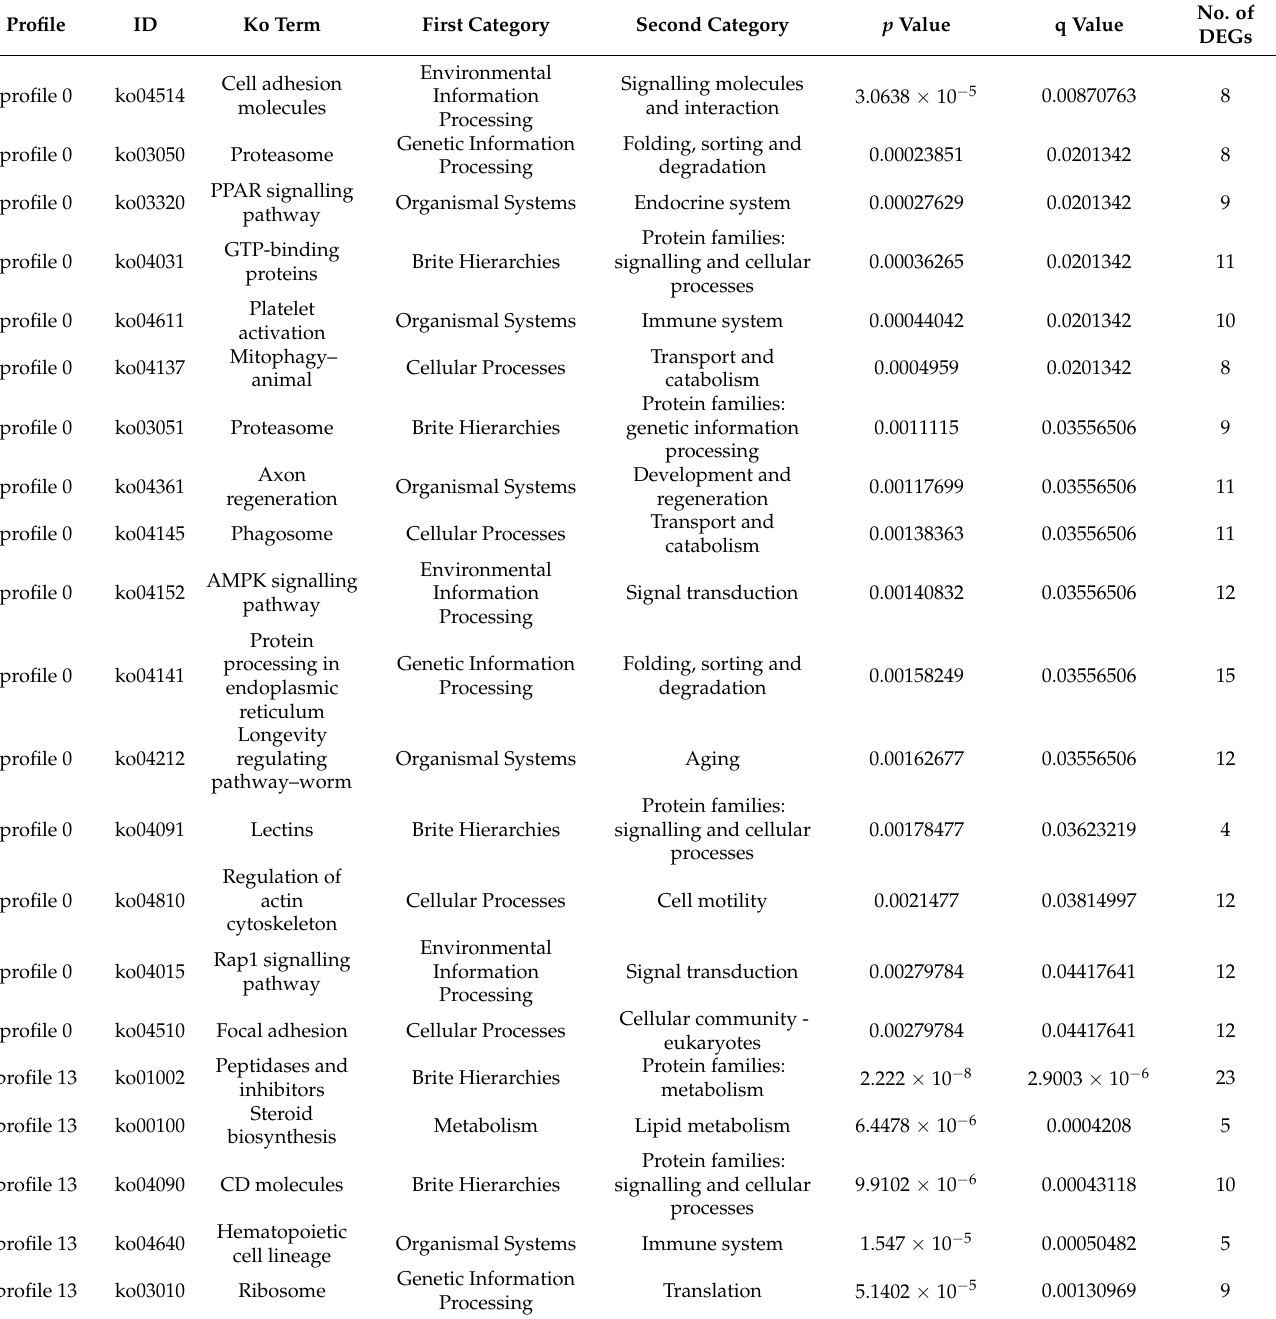
Table 3. KEGG enrichment of STEM analysis significant